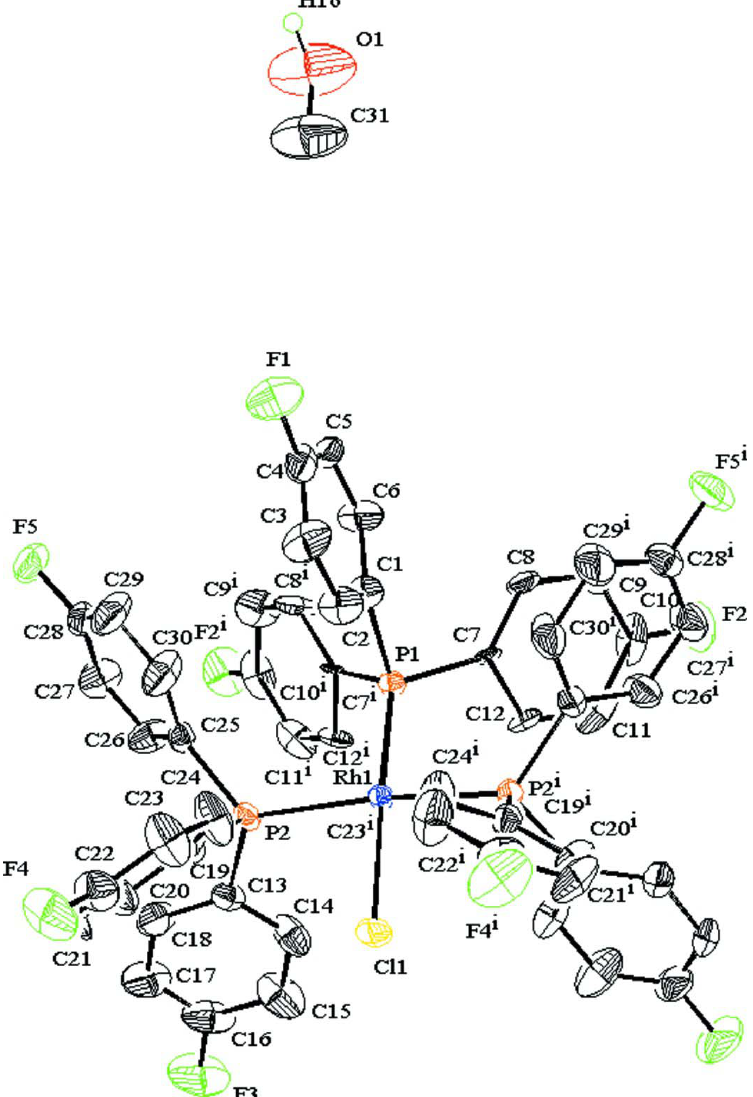
The molecular structure of title compound, with atom labeling scheme. Displacement ellipsoids are drawn at 50% probability level. H atoms are presented as a small spheres of arbitrary radius. Only major part of disordered molecular moieties are